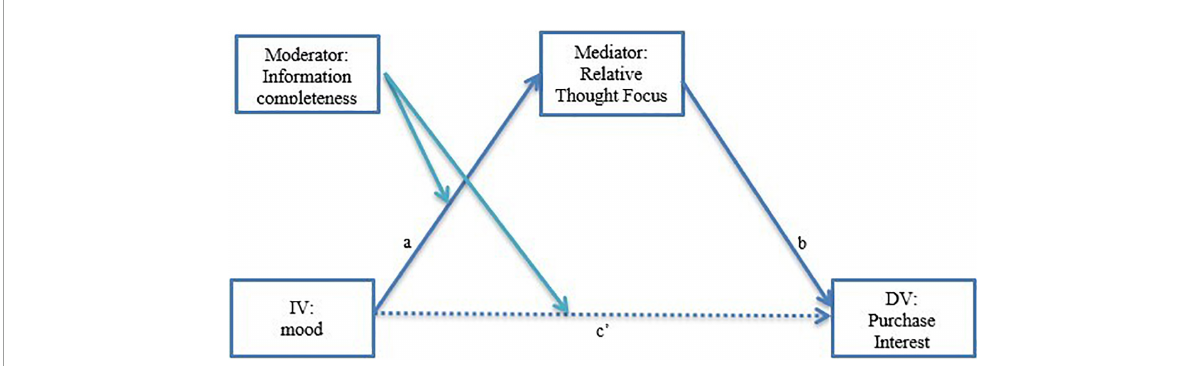
FIGURE3 Experiment 4: Moderated mediation (Model 8, Hayes, 2017) testing the effects of the mood on product evaluation through relative thought focus moderated by information completeness. Note: the model shows a significant conditional indirect effect (a,b) through relative thought focus only when information is missing (path a → b, p < 0.05; path c, ns ); when information is complete: path a → b, ns. The index of moderated mediation (Index = 0.27) shows that the conditional indirect effects are significantly different ( p < 0.05) across the two information completeness